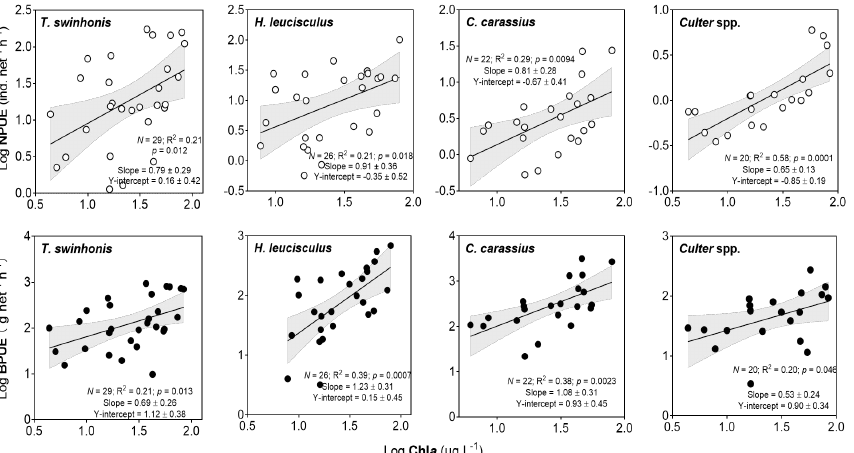
Figure 7. Relationships between catch per unit effort (NPUE and BPUE) of the three dominant fish species and piscivores and Chl a . N , number of lakes; Chl a , chlorophyll- a concentration in phytoplankton; NPUE, catch per unit effort in numbers; BPUE, catch per unit effort in biomass. Notes: Toxabramis swinhonis (zooplanktivore), Hemiculter leucisculus (omnizooplanktivore), Carassius carassius (omnibenthivore) and Culter spp. (piscivore). The dashed lines represent the 95% confidence band.